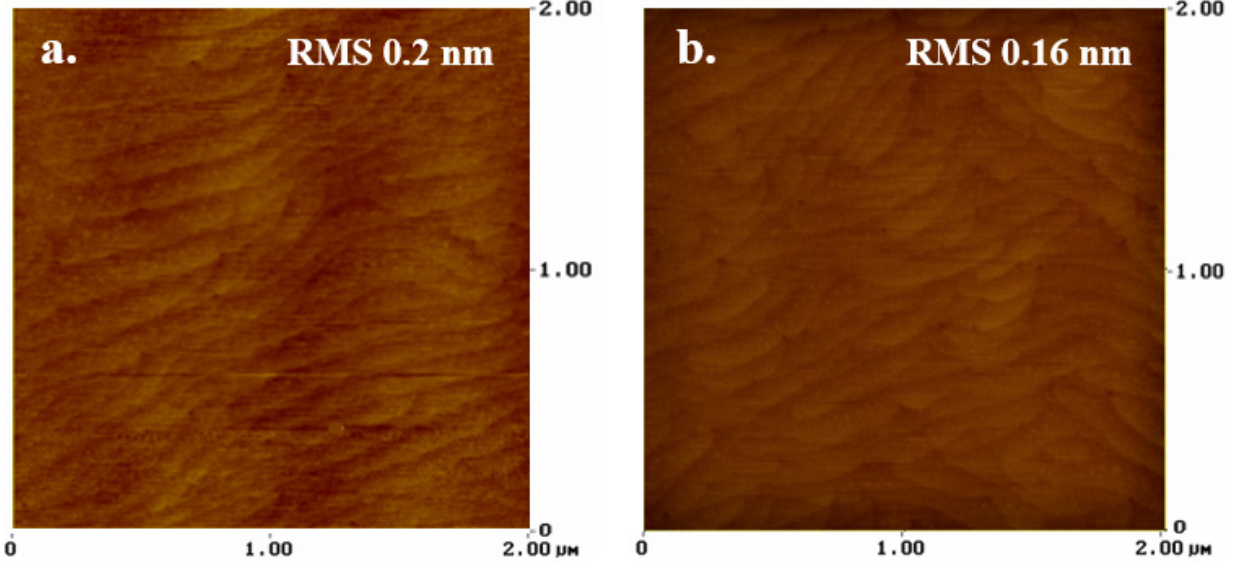
Figure 2. AFM images of 3 µm thick AlN layers grown by using ( a ) H 2 as a carrier gas and ( b ) a similar layer with N 2 as a carrier gas (Reprinted/adapted with permission from Ref. [9]. 2021, Springer Nature).